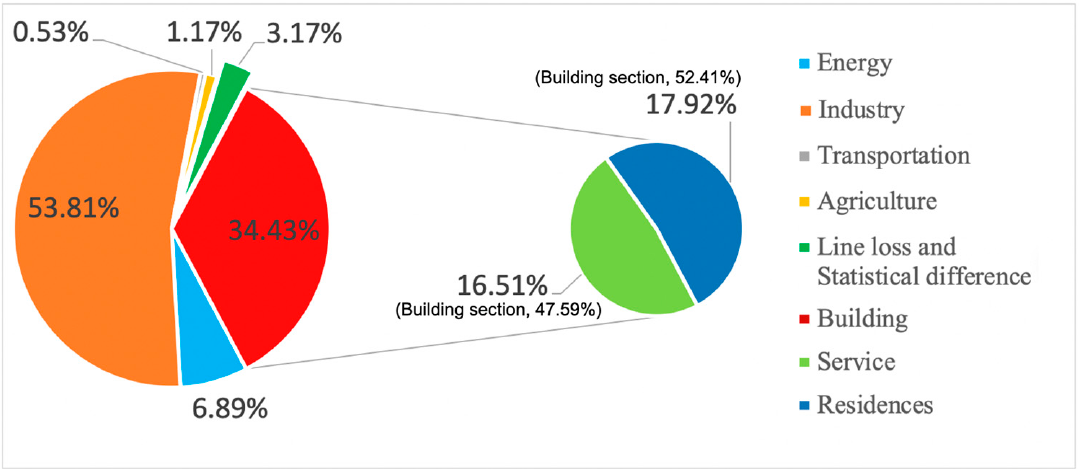
Figure 1. Total electricity consumption of Taiwan in 2020. (Data from Reference [2]).